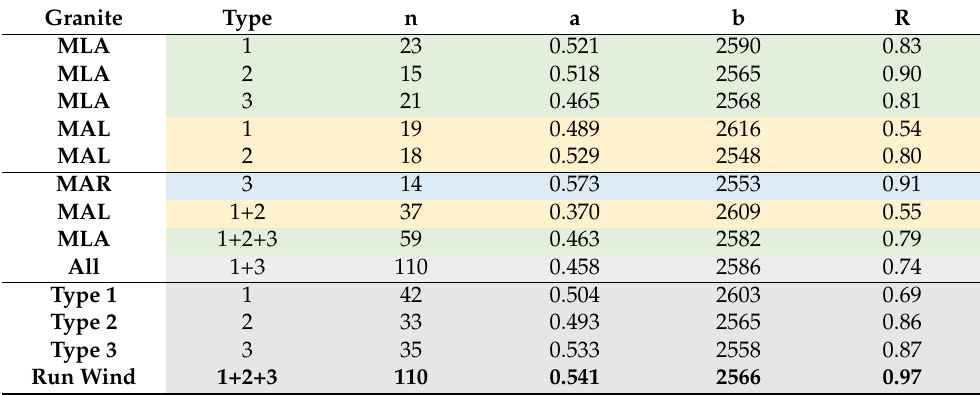
Table 4. Summary of density and magnetic susceptibility regressions ( ρ = a κ + b) found in our dataset as a function of the pluton and the sample type ( ρ in kg/m 3 and x = κ in 10 − 6 S.I., n; number of sites